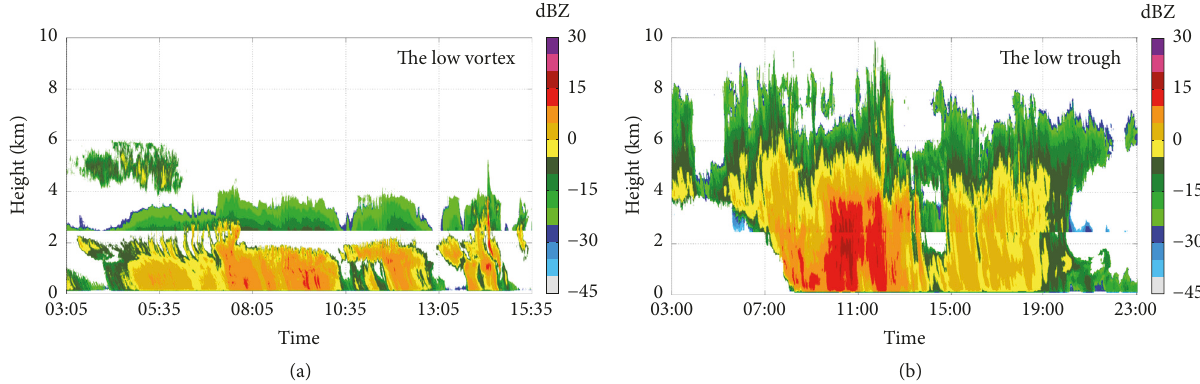
Figure 6: The echo evolution of cloud and precipitation at Yan Jiaping under typical low vortex (case 9, (a)) and low trough (case 11, (b)). The height in 𝑦 -axis is above the